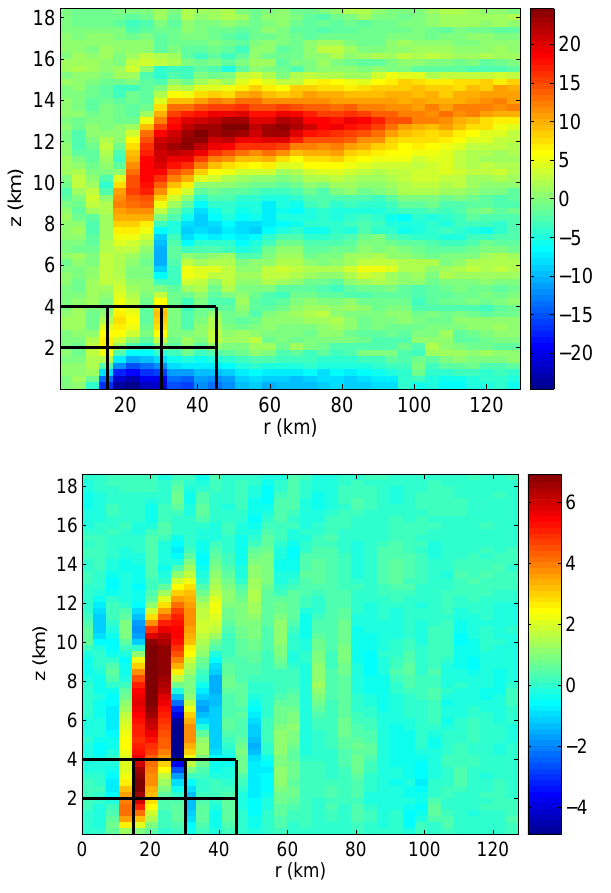
Fig. 1. Radial velocity field (a) and vertical velocity field (b) at t =400min. with boxes used for computing mixing rates in the lower left of each image.